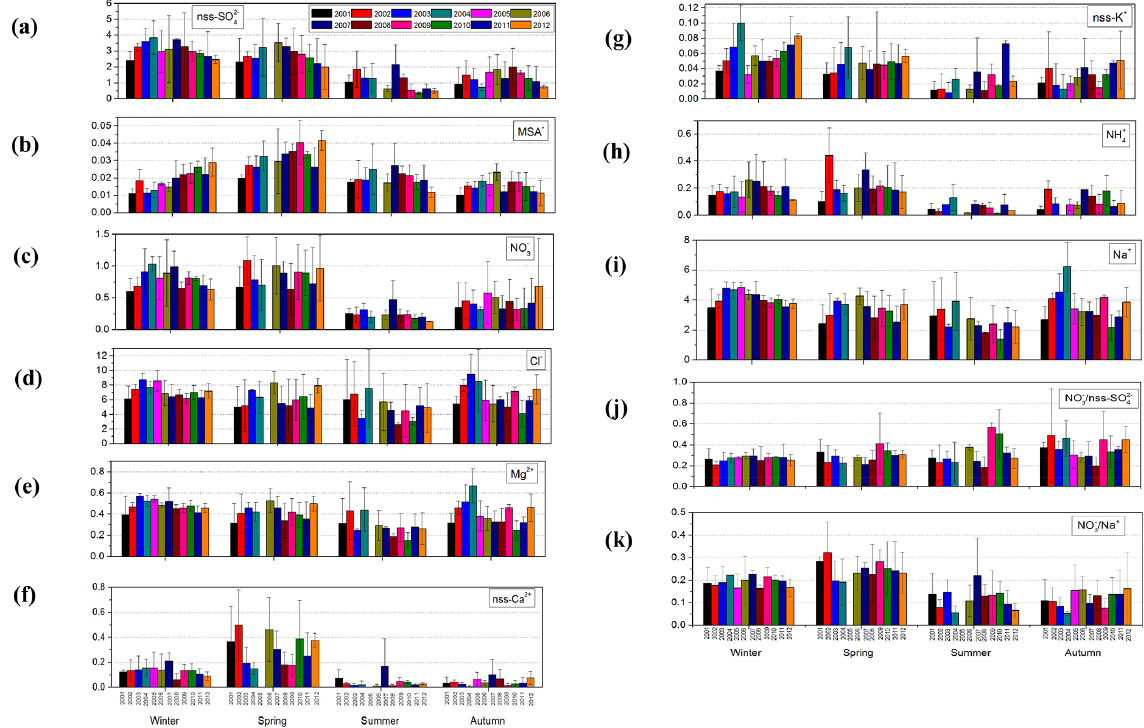
Figure 7. Annual variations of different chemical species (µgm − 3 ) on a seasonal scale over the sampling period of